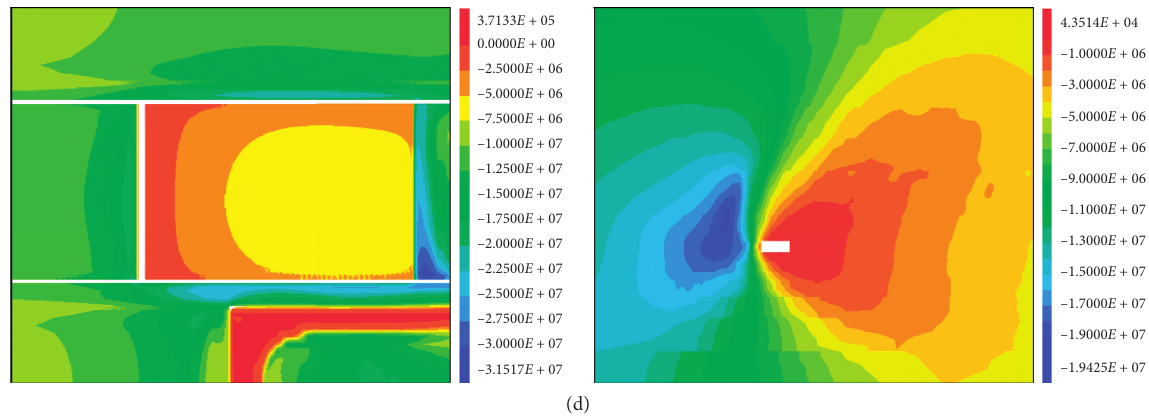
Figure 8: Nephogram of stress distribution 300m away from the cut hole in E1302 working face under a backfilling mining cycle. (a) Vertical stress distribution before cutting the first coal. (b) Vertical stress distribution before cutting the second coal. (c) Vertical stress distribution before backfilling. (d) Vertical stress distribution before the next coal cutting after